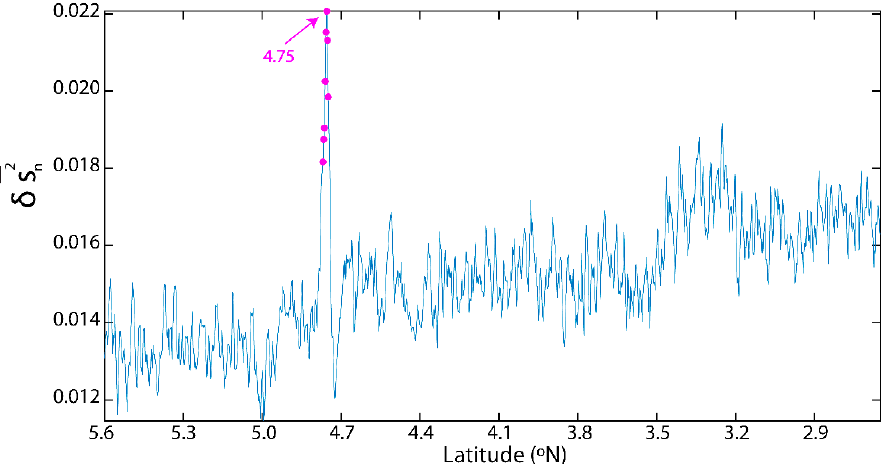
Figure 6. Differenced mean square slope record calculated from the dual-frequency synthetic aperture radar altimeter (SRAL) altimeter with the result of the automatic algorithm designed in this paper for relative orbit 152 of cycle 036, dated 27 September 2018, after the procedure described in the logic flow diagram of Figure 2 is applied.